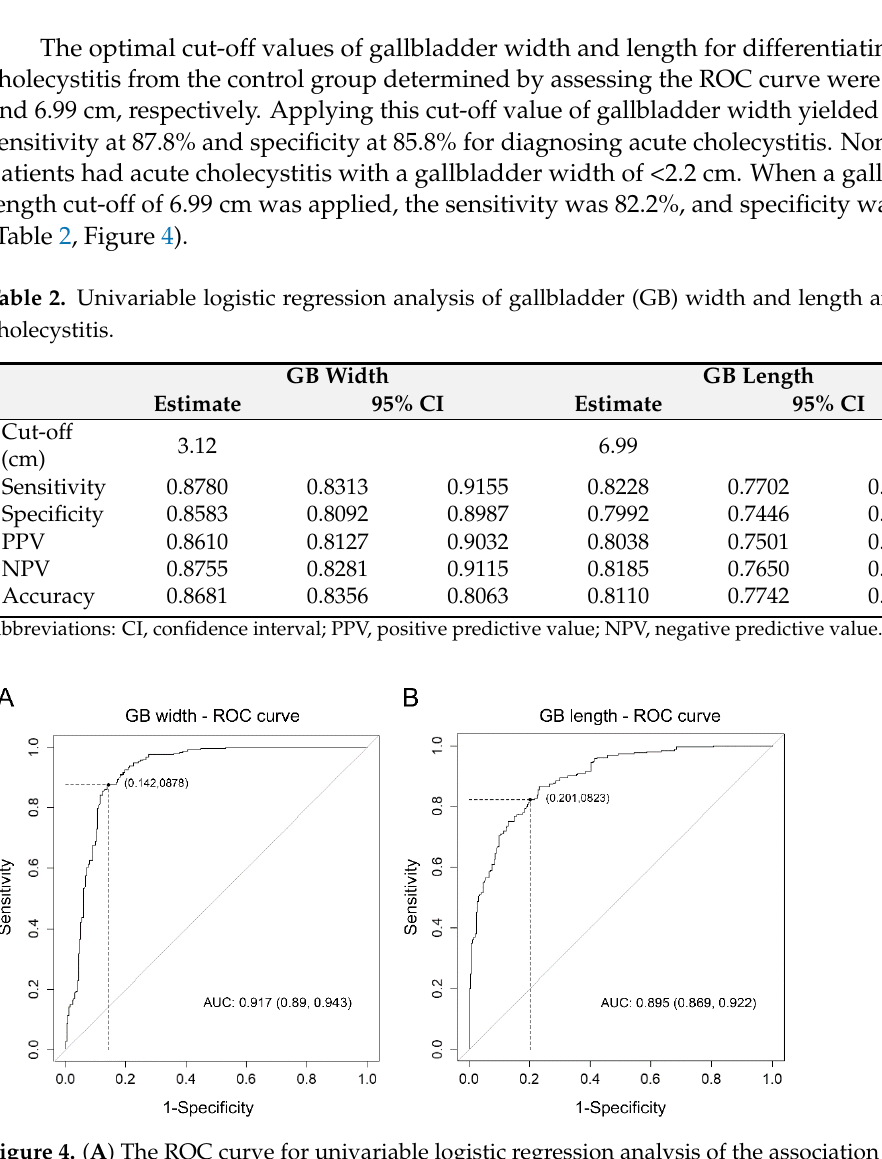
Figure 3. Box plot of acute cholecystitis and control group by gallbladder (GB) width ( A ) and length ( B ).